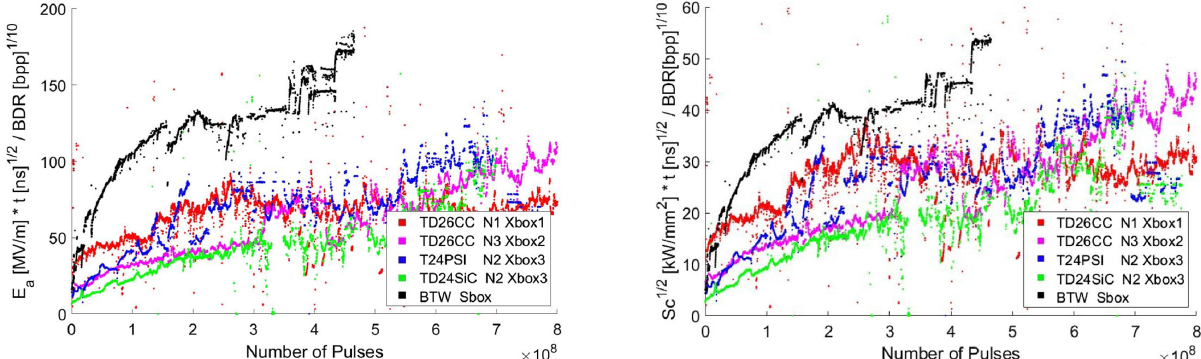
FIG. 21. Comparison of the scaled accelerating gradient (left) of the first cell and the scaled peak modified Poynting vector S t 5 with respect to the number of pulses for: TD26CC N1 (Xbox-1), TD26CC N3 (Xbox-2), T24PSI N2 (Xbox-3), assuming BDR ∝ E 10 a T24SiC N2 (Xbox-3), and BTW N1